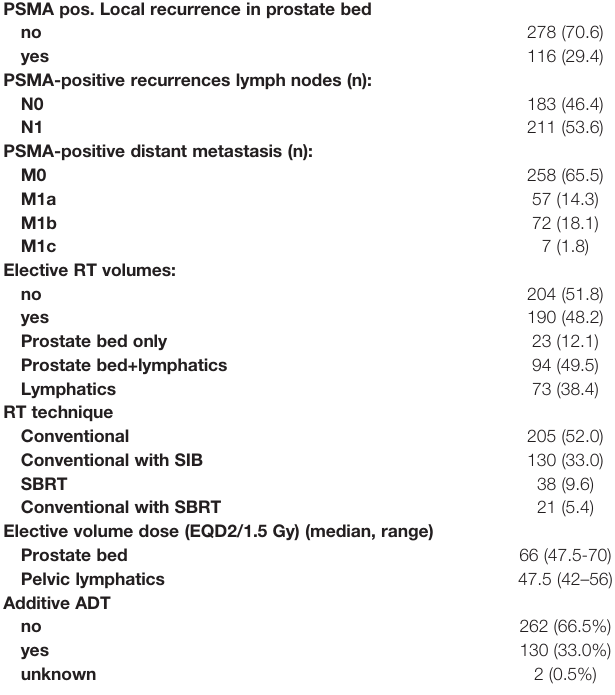
TABLE 2 | Patterns of recurrence and elective treatment areas. PSMA pos. Local recurrence in prostate bed